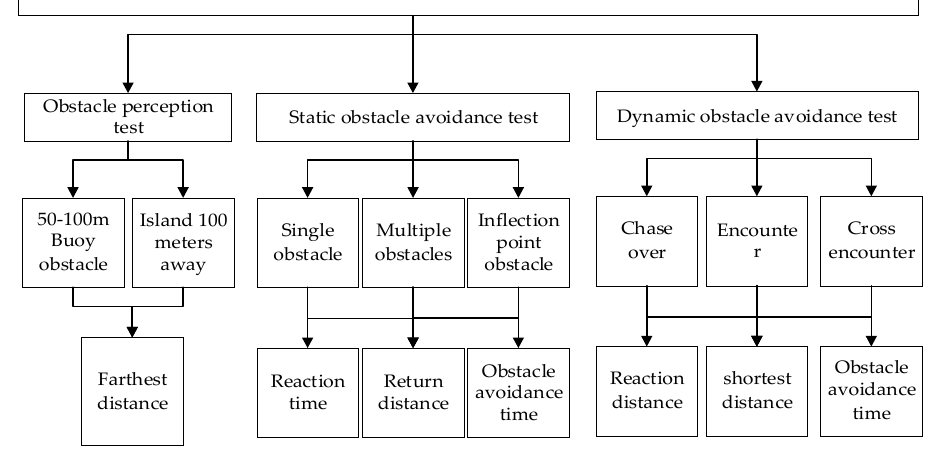
Figure 2. Evaluation index system for the obstacle avoidance performance of unmanned ships.